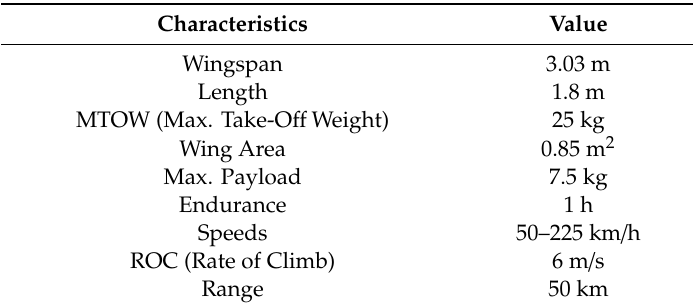
Table 6. ALO RPA technical